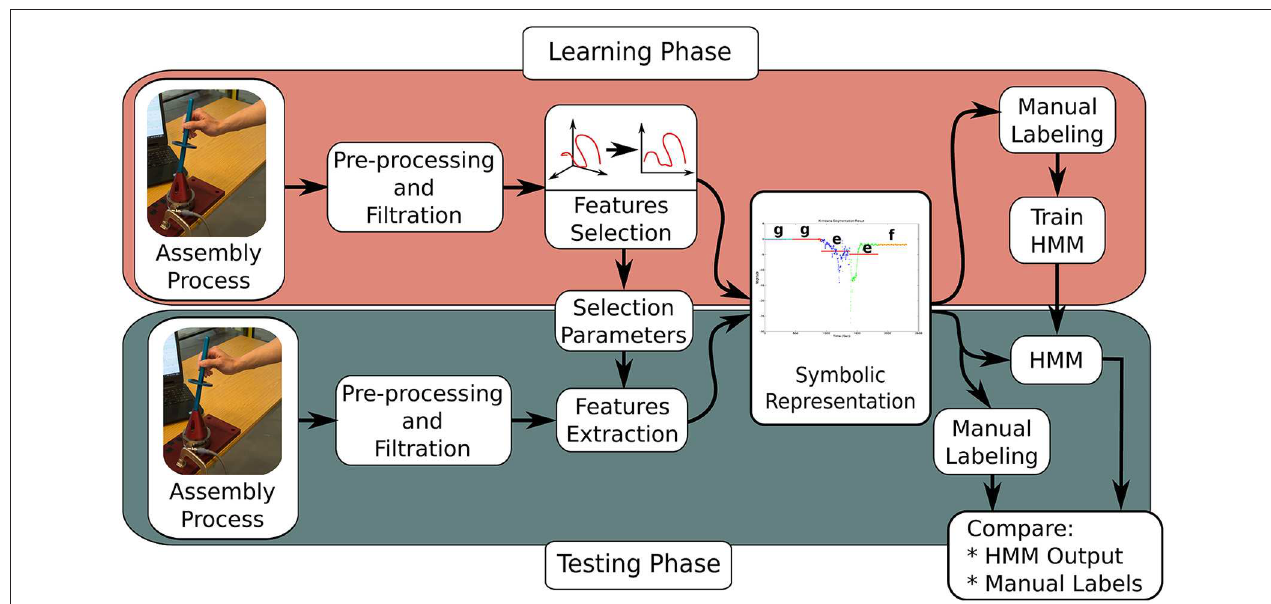
FIGURE 1 | Overview of the proposed approach (training and testing